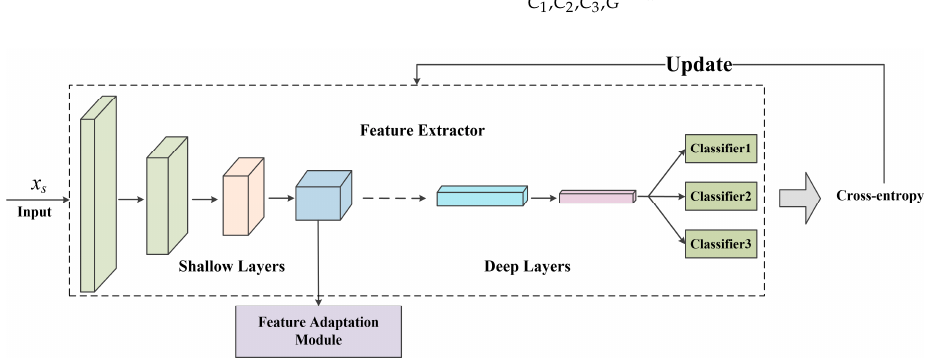
Figure 5. Training the model on the source domain.